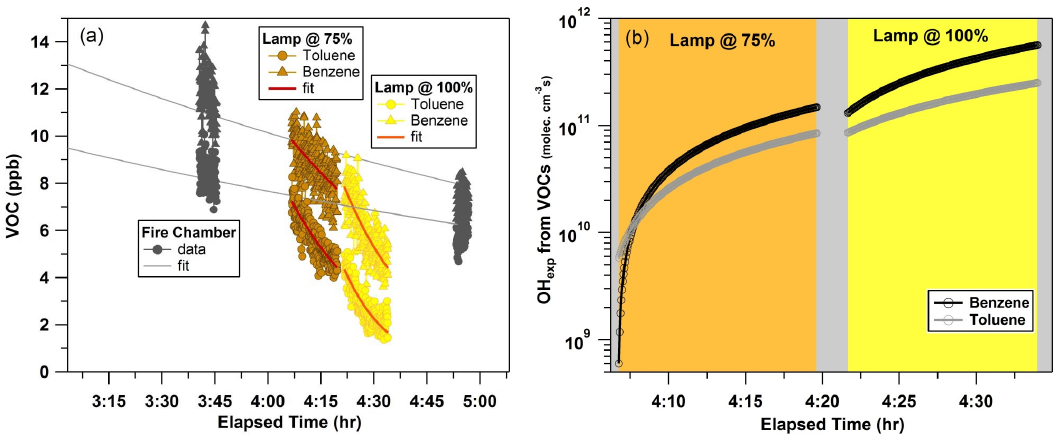
Fig. 2. Time series of VOC observations in the reactor at two different UV lamp settings used to calibrate OH exp . Percentage of light reported is one lamp at 75 or 100% of maximum supplied voltage. (a) Data from burn 55, white spruce, showing fire chamber measurements of toluene and benzene made by PIT-MS (gray points). A fit of the dilution of the fire chamber concentrations is shown as a solid gray line. Flow reactor measurements of toluene and benzene are colored brown and yellow, respectively. Fits of the VOC concentrations after the flow reactor were used to calculate OH concentrations. (b) OH exp in the reactor calculated from PIT-MS benzene and toluene